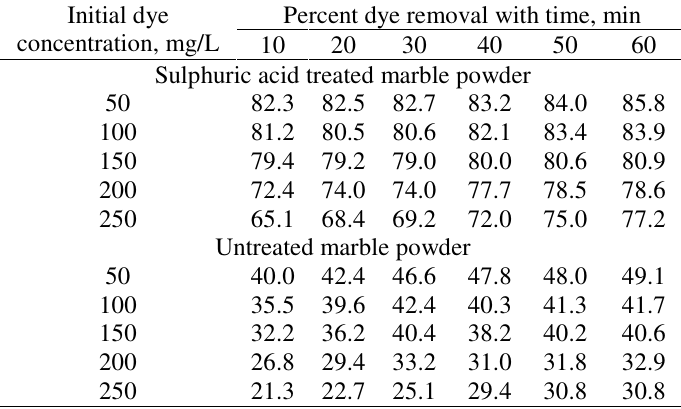
Table 3. Effect of methylene red concentration on the dye